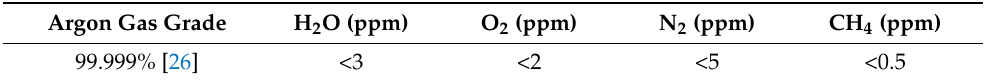
Table 3. Argon gas